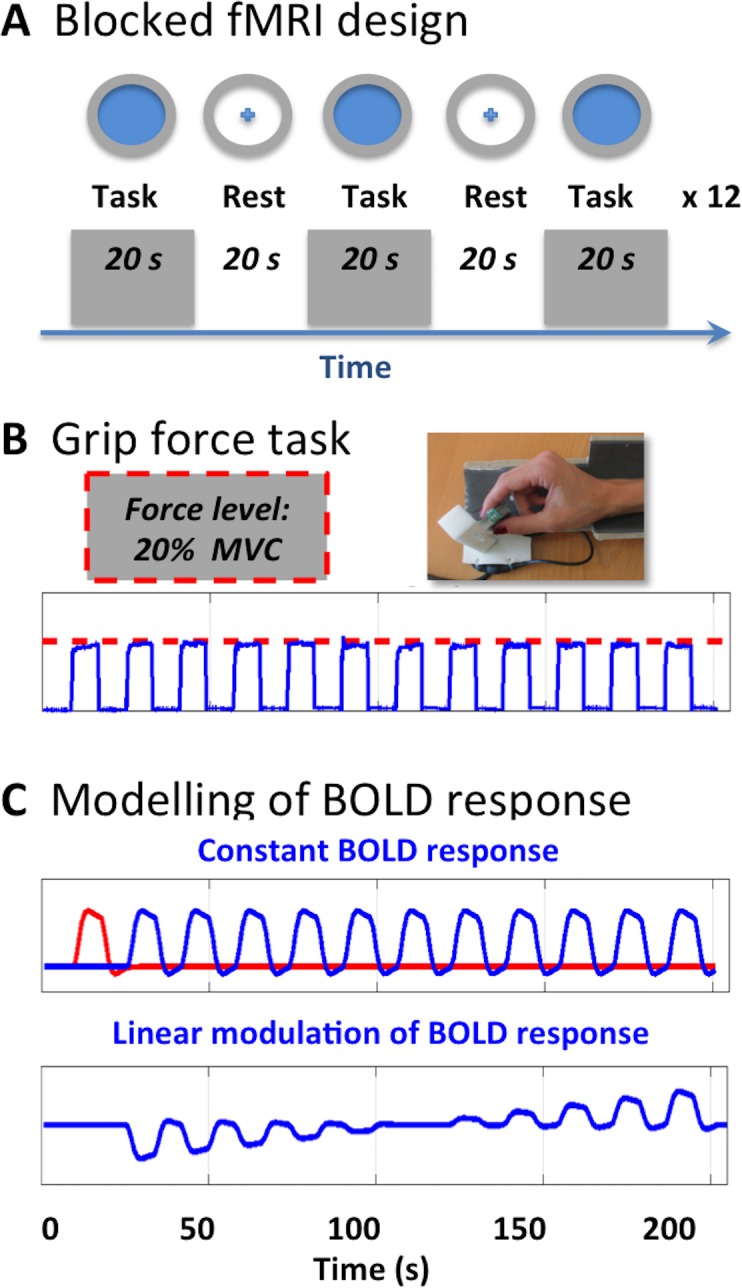
The precision grip task and parametric modulation.(A) The tonic precision grip task consisted of 12 task blocks (each 20 s) alternated by periods of rest (20 s). During the grip task, visual feedback of the exerted grip force (blue area) and the required target force (grey circle) was continuously provided. (B) Participants had to maintain a target force corresponding to 20% of the individual maximal voluntary contraction and the grip force output was continuously recorded. (C) Task-related activity was analysed using a General Linear Model in which the constant main effect of task (main effect) as well as linear modulation of task-related activity (linear time effect) were modelled. Task-related activation during the first block (red line) was separately modelled and treated as effect of no interest.